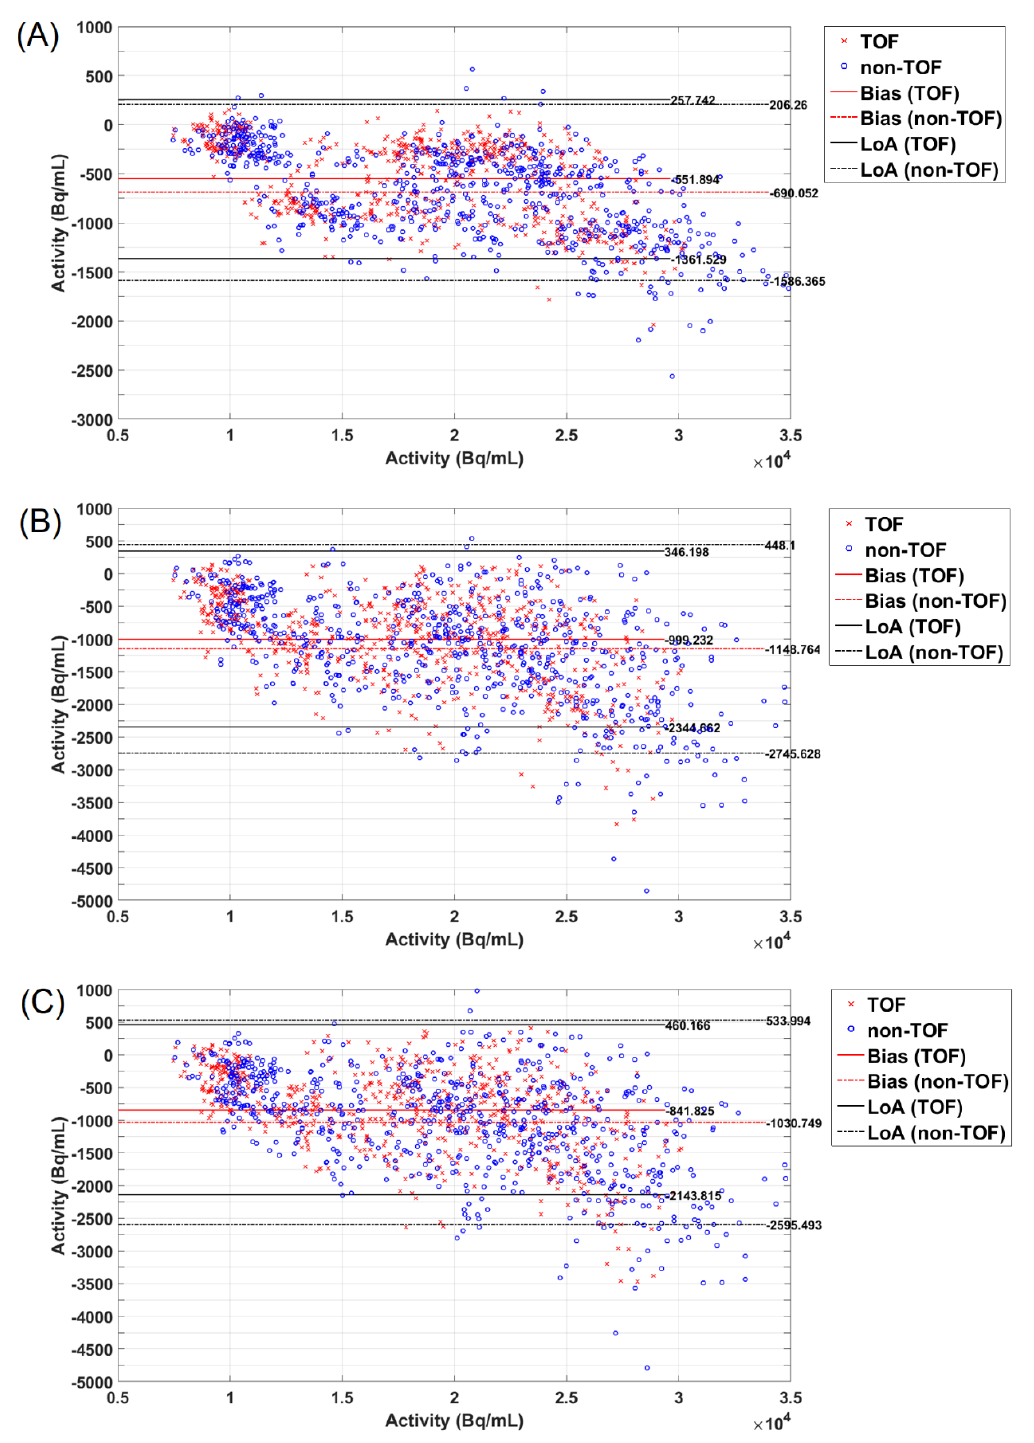
Figure 4. Bland–Altman plots of non-TOF (marked as blue ‘o’ symbol, and dashed lines) and TOF (marked as red ‘×’ symbol and solid lines) reconstructed activity values with different MRAC methods versus CTAC reconstructed PET. ( A ) 3−class MRAC, ( B ) 2−class MRAC, ( C ) 2−class MRAC without air cavities. The horizontal lines correspond to mean bias and limits of agreement (LoA).